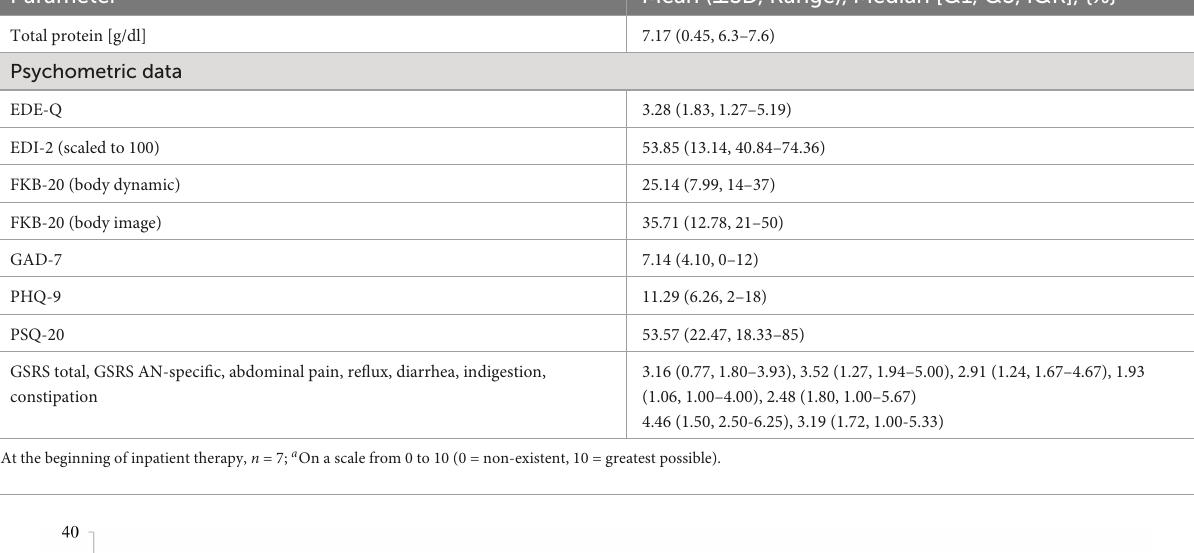
bulimia nervosa by EDI-2 (23) was higher than levels reported before in patients with AN (7, 32) (mean EDI-2 score scaled to 100: 53.9). For the assessment of body image, both subscales of the questionnaire FKB-20 were considered. The conception of the energetic aspect was similar to values previously recorded for patients with AN or depressive disorder but below the value calculated for patients with a somatoform disorder (33) (mean FKB-20 body dynamics score: 25.1). The body image score (mean: 35.7) was higher in comparison to the one observed in